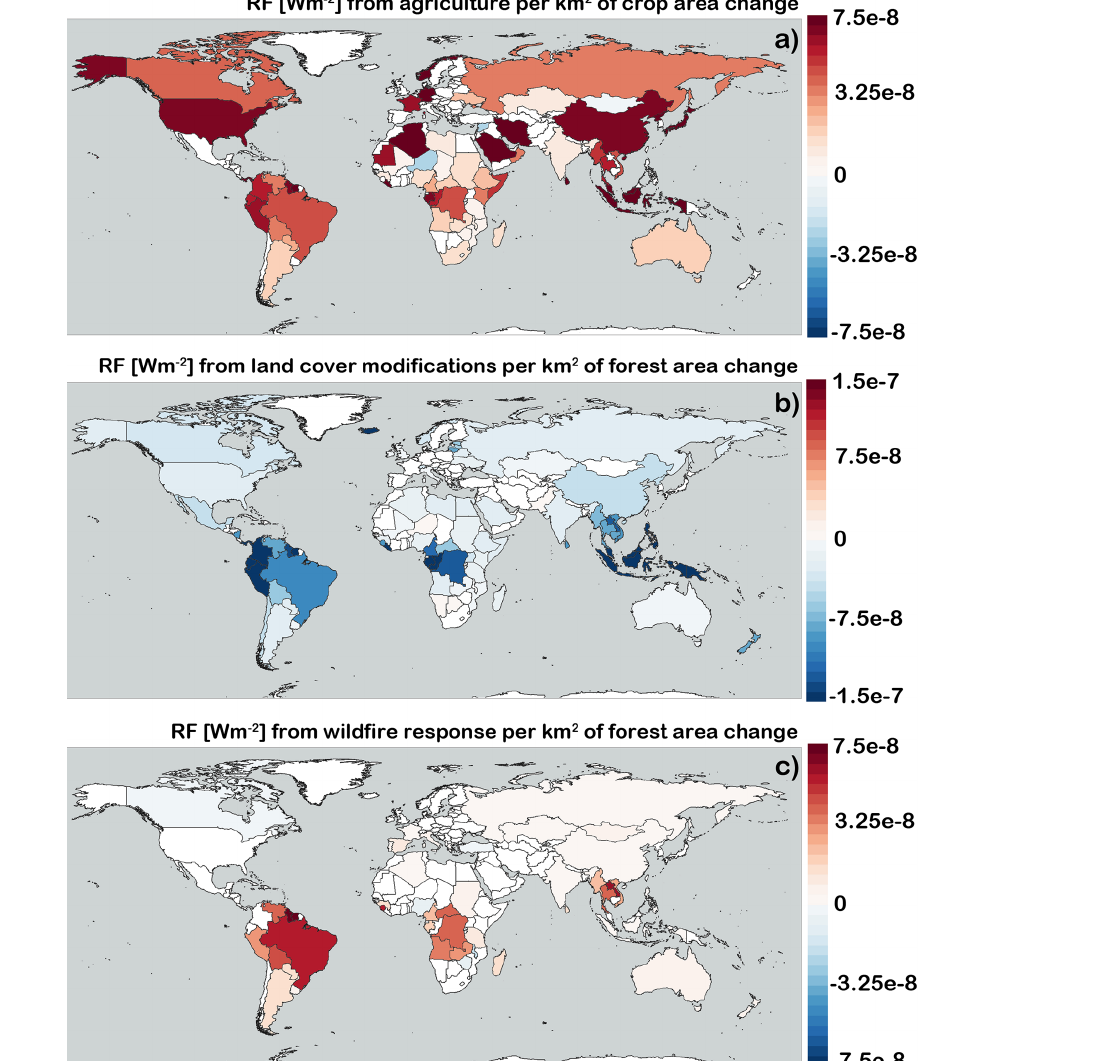
Figure 9. Slope of the regression of year 2100 RF from (a) agricultural activities, (b) direct modifications to land, and (c) associated changes in wildfires between 2010 and 2100 onto the change in (a) global crop area and (b) , (c) global forest area between 2010 and 2100 for each country. Regression coefficients are plotted when the relationship between RF and changes in land cover is significant at a 95% confidence level (two-tailed test) using the Spearman rank correlation